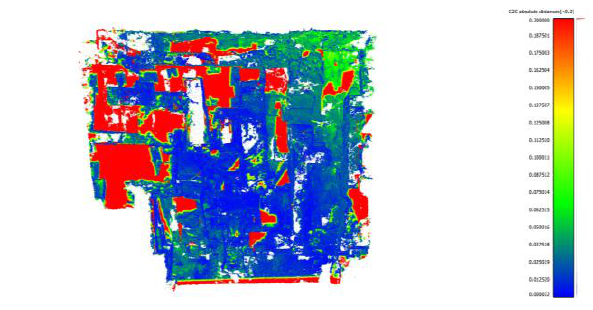
Figure 9. Comparison between the laser scanner point cloud